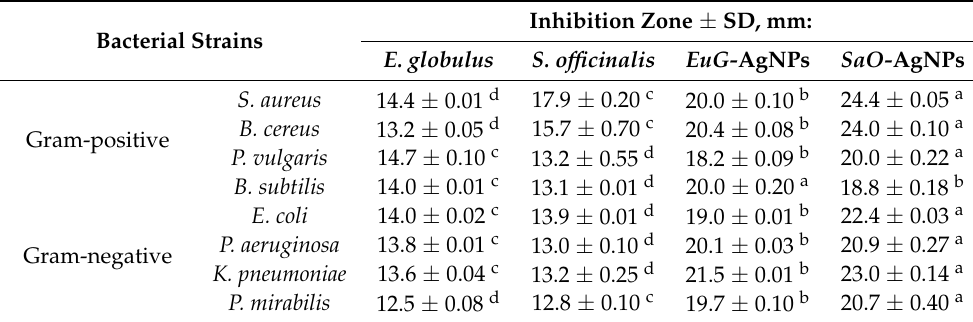
Table 3. Inhibition zones of the plant extracts and AgNPs against Gram-positive and Gram-negative bacteria strains ( p >